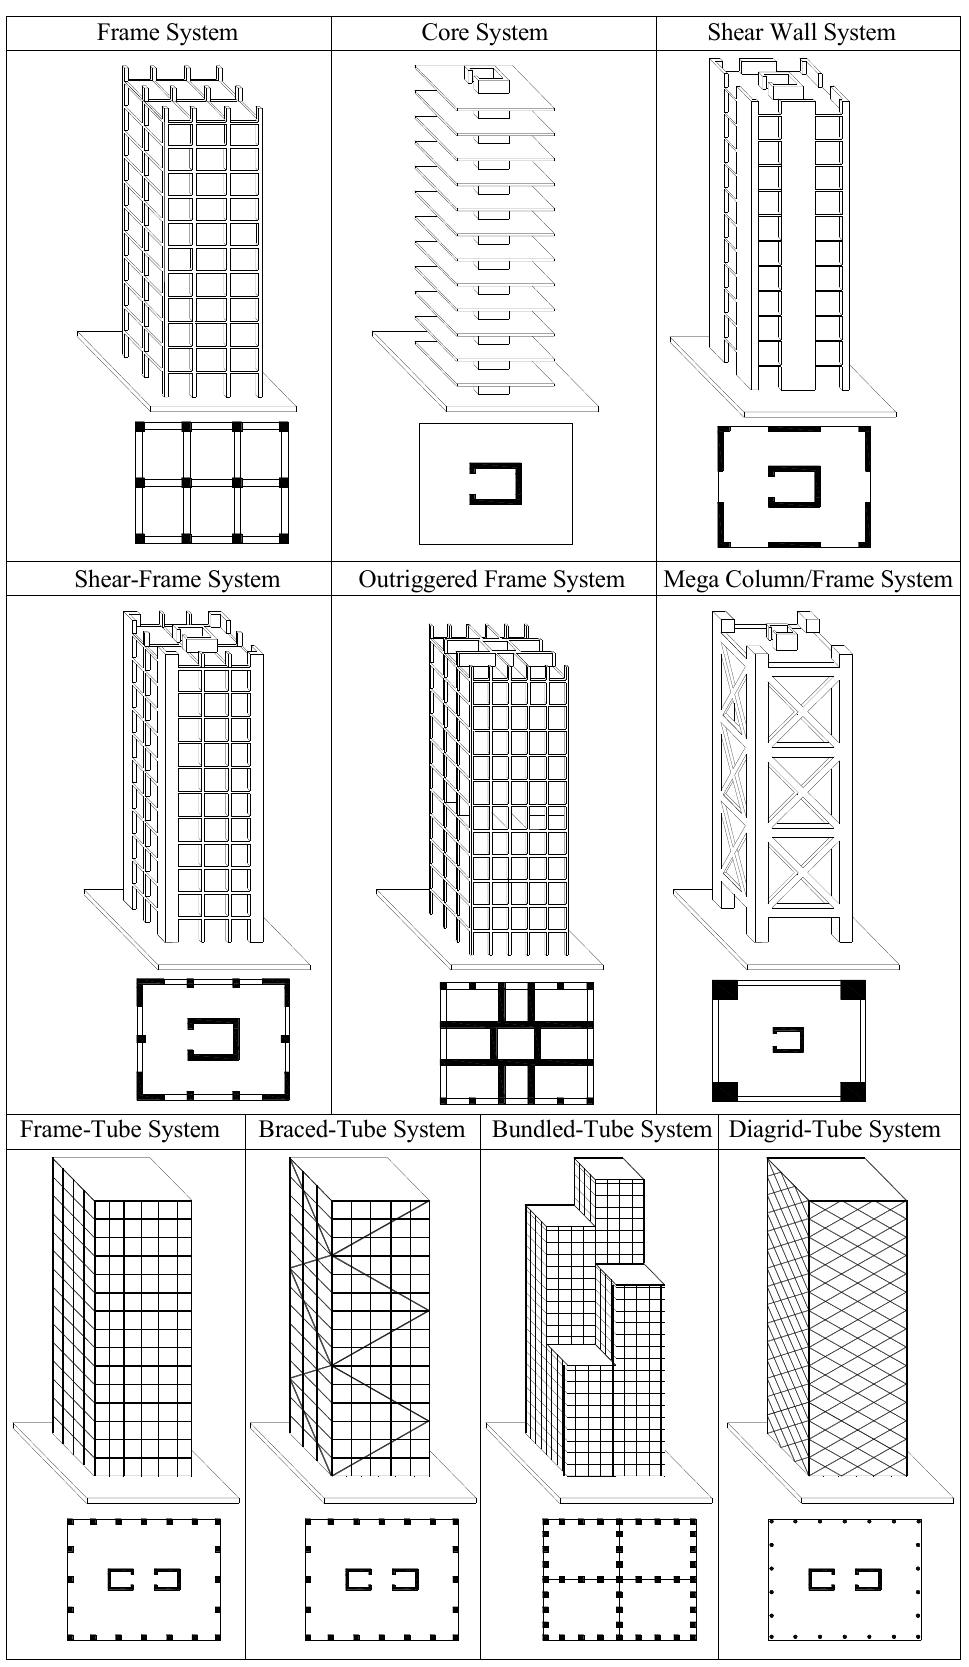
Figure 10. Structural system classification for tall buildings.